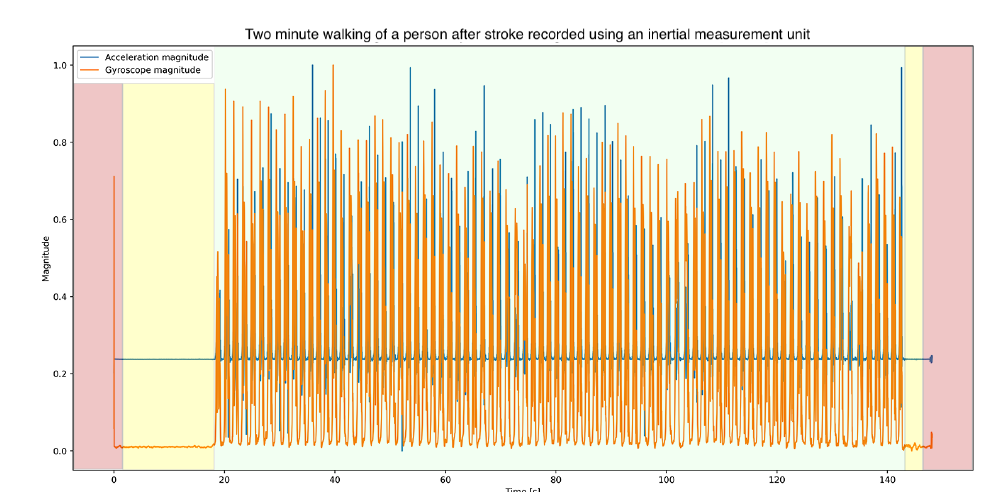
Figure 1. Visualisation of the data-processing steps prior to calculating the gait features. In the figure, the acceleration magnitude (blue) and gyroscope magnitude (orange) of a two-minute walking assessment is depicted. Firstly, the first and last two seconds (red planes) were excluded from analysis. The remaining signal was then used to calculate the threshold to determine the prior- and post-walking stationary periods (yellow planes). The residual signal was included in further